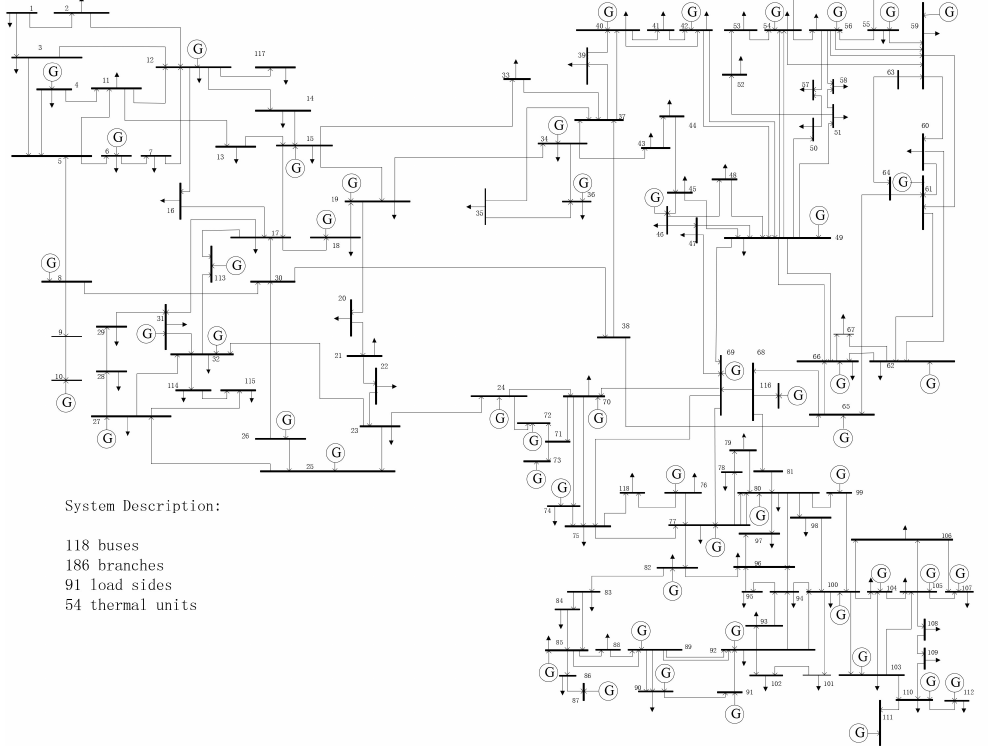
Figure 2. IEEE 118 bus system